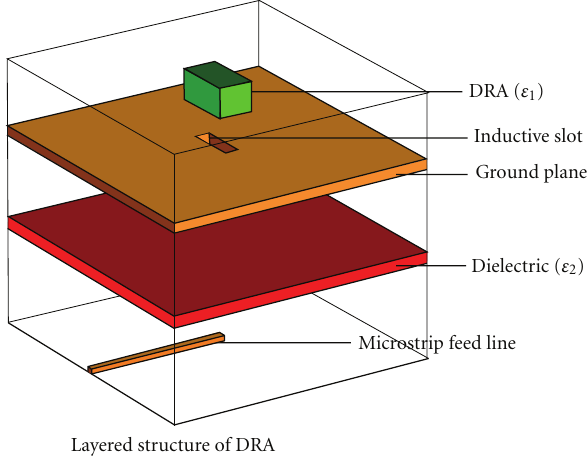
Figure 1: Layered structure of